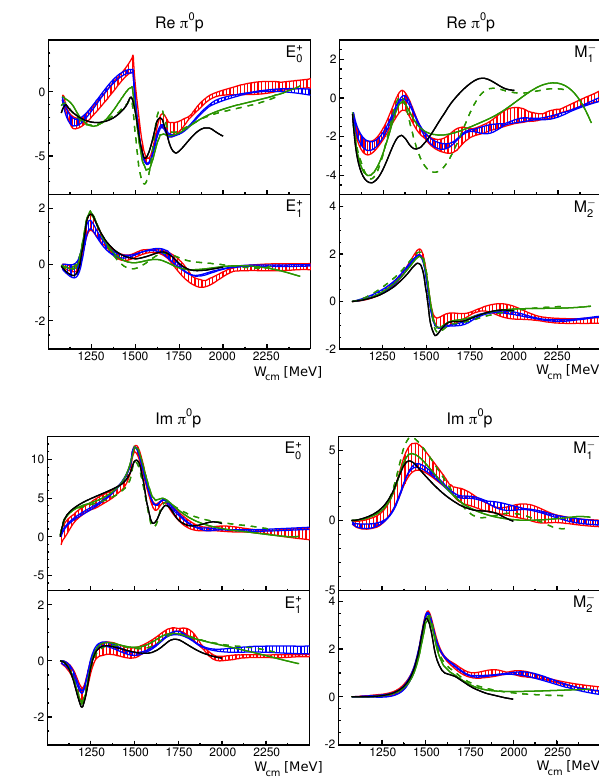
Figure 10. the real and imaginary parts of the E 0 + , E 1 + , M 1 − and M 2 − multipoles of the p π 0 final state are depicted. The red areas represent a variety of di ff erent fits of the BnGa2011-01 and BnGa2011-02 PWA [42], that do not include the new po- larization data, while the blue areas represent the variety of solu- tions when including the new polarization data (BnGa-2014-02 PWA solution [15, 41]). In addition, the MAID (black line) [18], SAID-CM12 (solid green line) [17], SAID-SN11 (green dashed line) [52] and the JüBo-2015 (magenta line) [50] PWA fit solu- tions are shown as well. Taken from